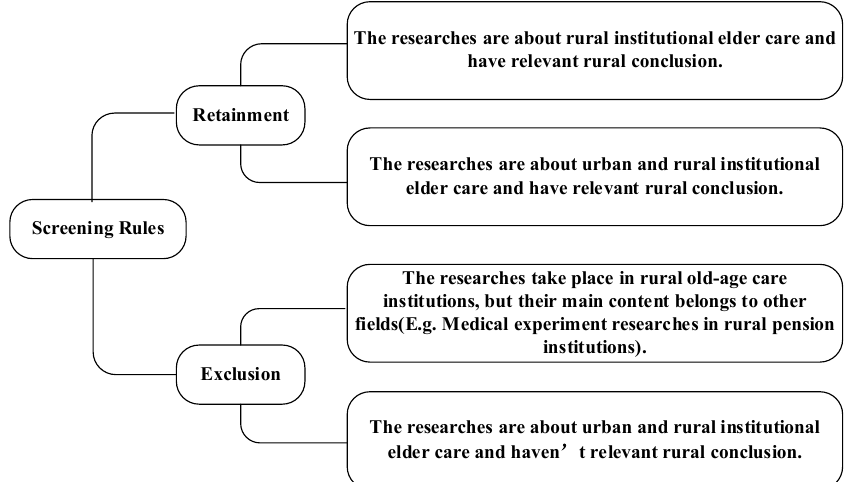
Figure 2. The rules of screening